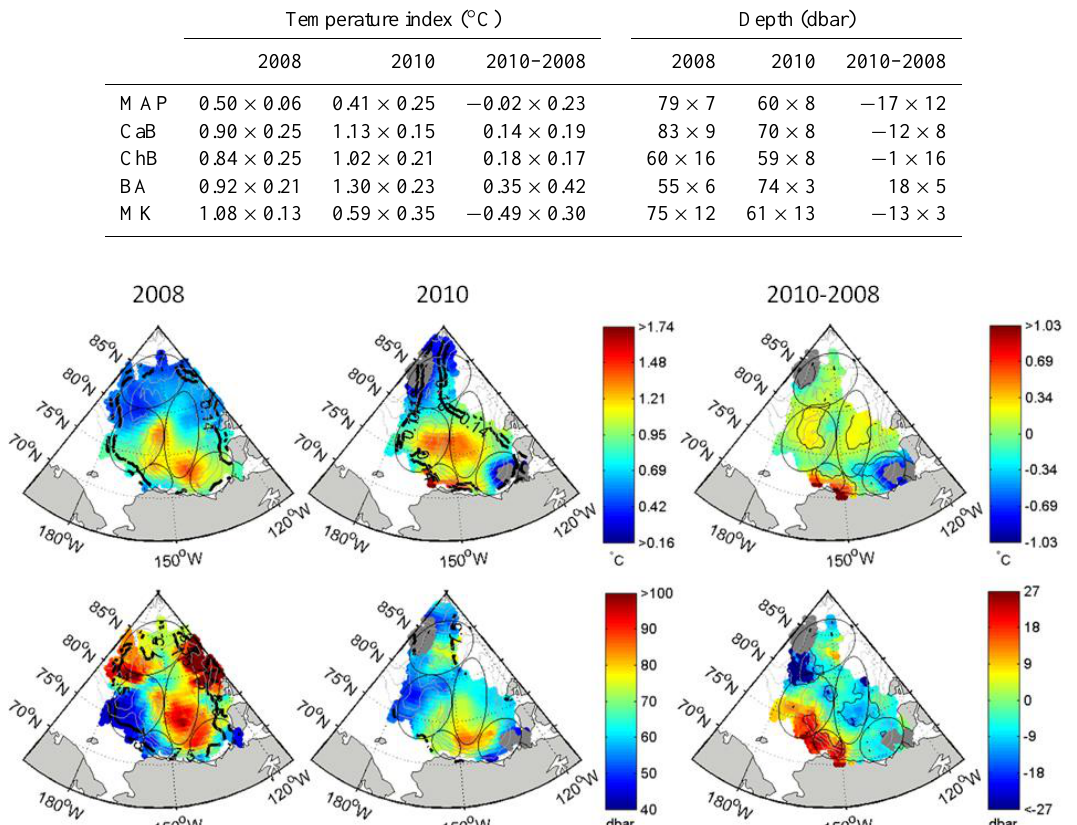
Figure 8: Kriging interpolation of the SPaW index, T -T (top), and its depth level (Z , SPaW FP SPaW Fig. 8. Kriging interpolation of the SPaW index, T SPaW - T FP (top), and its depth level ( Z SPaW , bottom), for years 2008 (left panel) and 2010 bottom), for years 2008 (left panel) and 2010 (middle panel), and the evolution between the (middle panel), and the evolution between the two years (right panel). Grey areas correspond to the absence of the SPaW. In the left and two years (right panel). Grey areas correspond to the absence of the SPaW. On the left and middle panels, thick black dashed isolines correspond to estimation error ( σ ) due to Kriging interpolation process. The isolines represented middle panels, thick black dashed isolines correspond to estimation error (σ) due to Kriging are σ = 0.14 ◦ C and σ = 0.18 ◦ C for SPaW index, and σ = 7.5dbar and σ =8.5 dbar for Z SPaW . In the right panel, thin black isolines interpolation process. The isolines represented are σ = 0.14°C and σ = 0.18°C for SPaW correspond to 95% index, and σ = 7.5dbar and σ = 8.5 dbar for Z . On the right panel, thin black isolines SPaW correspond to 95% significance.